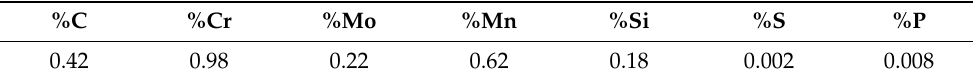
Table 1. Chemical composition (weight %) of the 42CrMo4 steel used in this study.